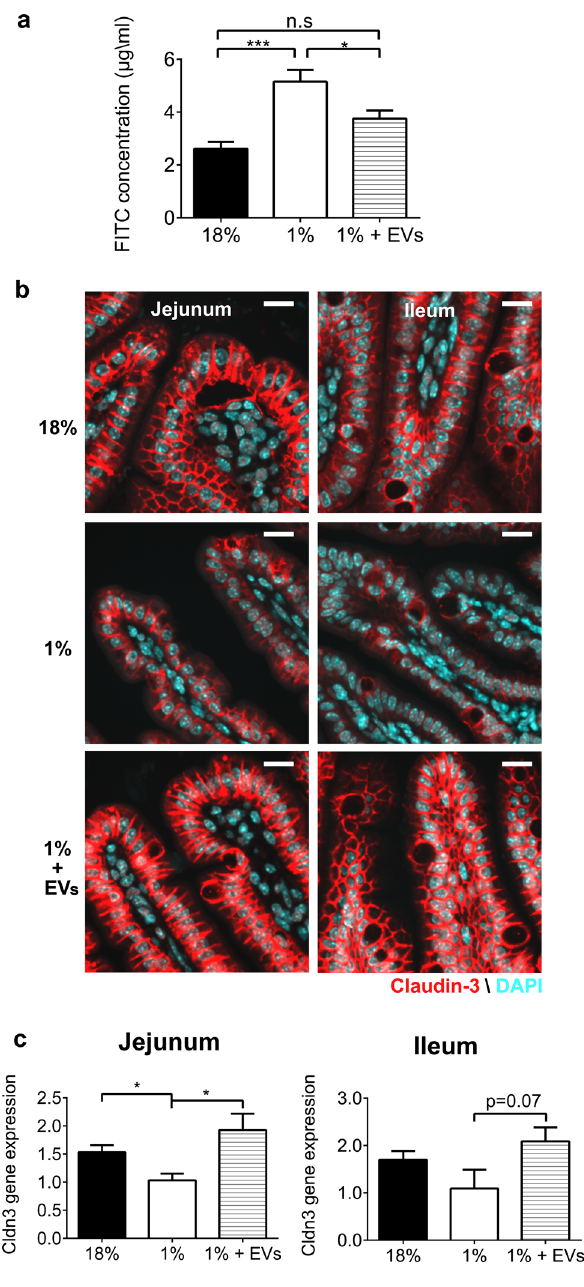
Figure 4. Milk EVs improve intestinal permeability and barrier protein claudin-3. Indicators of barrier function in controls, i.e. sham treated mice fed 18% diet; sham-treated mice fed 1% protein diet; and milk EV-treated mice fed 1% protein diet as represented by: ( a ) Fluorescein isothiocyanate dextran (FITC) assay of intestinal permeability (n = 7/group). Each column represents mean ± standard error of mean (SEM); ( b ) Immunofluorescent staining for intestinal epithelial barrier protein claudin-3 (red) in the jejunum and ileum with DAPI counterstaining of nuclei in blue, n = 3/group; 40 × magnification (Scale bar, 15 µm). ( c ) Claudin-3 ( Cldn3 ) mRNA expression relative to ribosomal protein L13A (Rpl13a) in the jejunum and in the ileum (n = 6/ group). Each column represents mean ± standard error of mean (SEM). *** P < 0.001, * P < 0.05, n.s = not significant. Graphs and statistical tests were done using GraphPad Prism version 6.0.0 for Windows (www. graph pad.